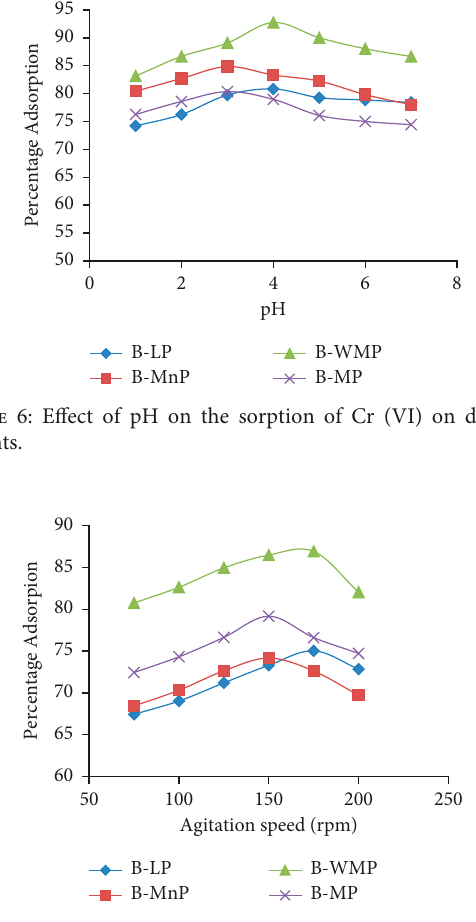
Figure 7: Effect of agitation speed on the sorption of Cr (VI) on different